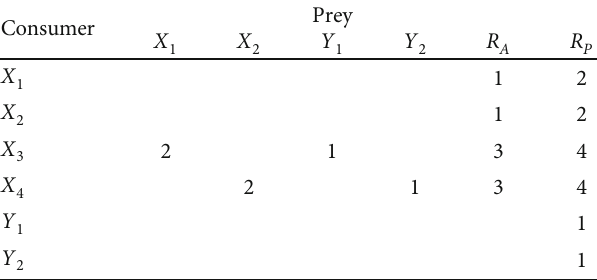
Table 2: Food preferences of African cat fi sh and Nile tilapia: the elements in the fi rst column eat the elements in the fi rst row in a preferred order, where it prefers the food with the lowest number. If no number exists, then it does not eat the corresponding food. The variable descriptions are given in Table